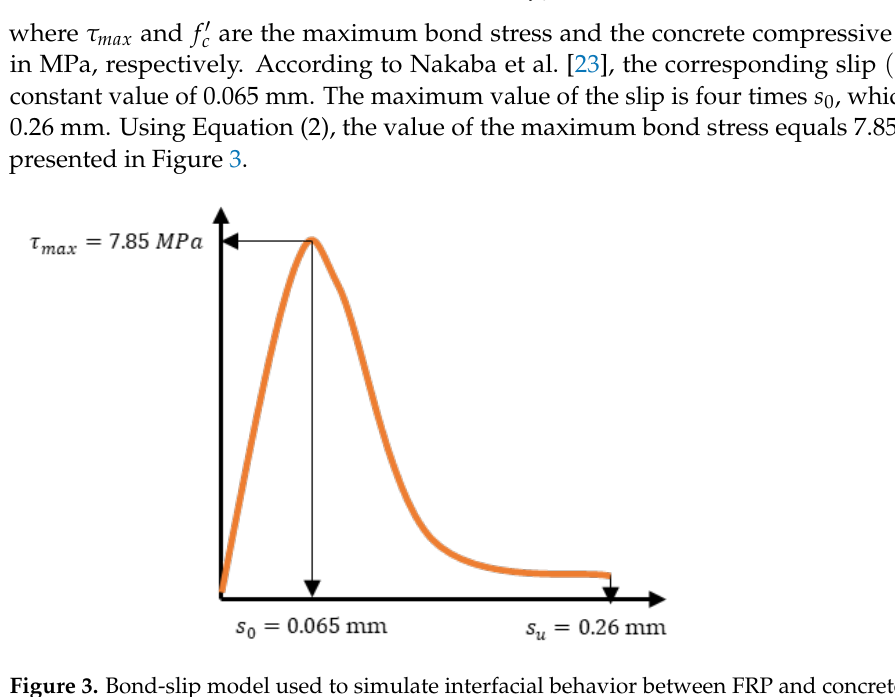
Figure 3. Bond-slip model used to simulate interfacial behavior between FRP and